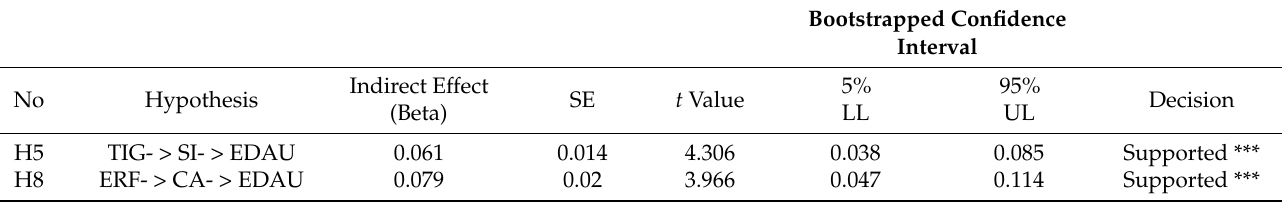
Table 5. Summary of mediation